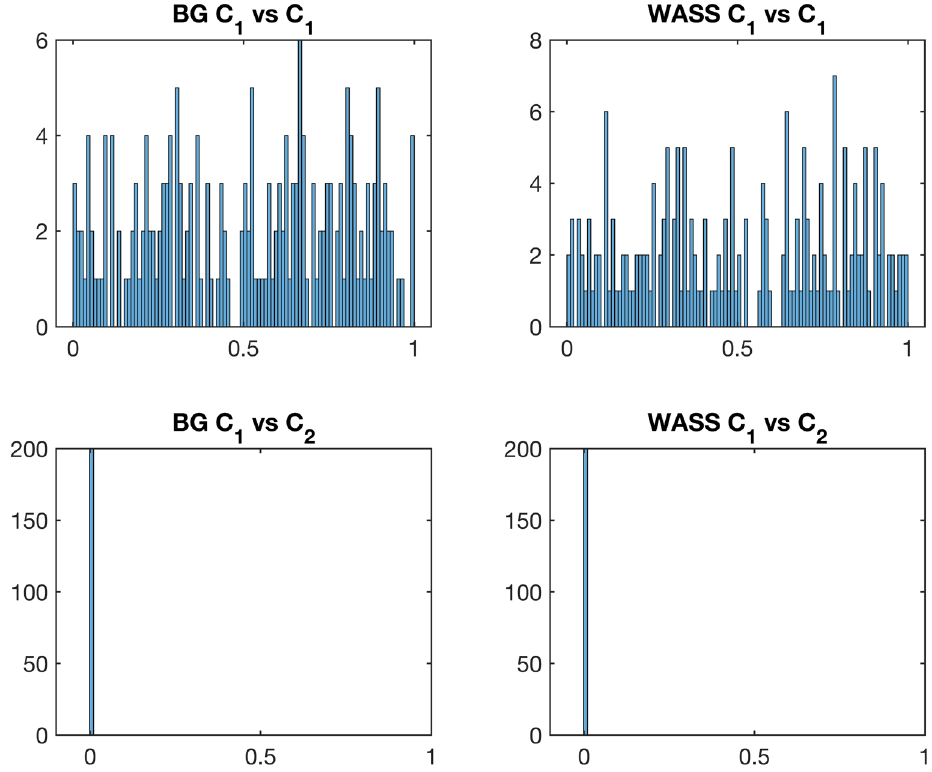
Figure 4. Hypothesis testing for two sets of correlation matrices driven from a model correlation matrix C 1 or from two different model correlation matrices C 1 and C 2 . Each set contains 30 random samples from the model correlation matrix. Empirical distributions of 200 p values by Biswas–Ghosh (BG) and Wasserstein (WASS)- based tests are